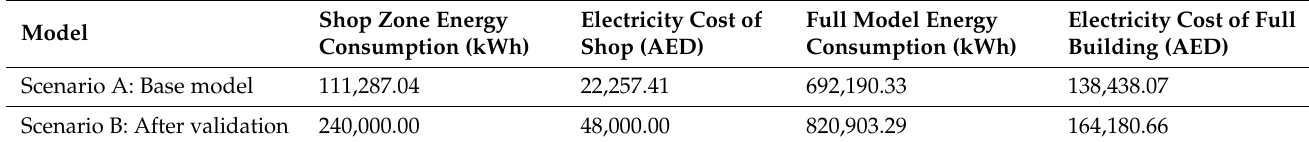
Figure 10. Base model occupancy schedule. Table 2. Energy consumption of base